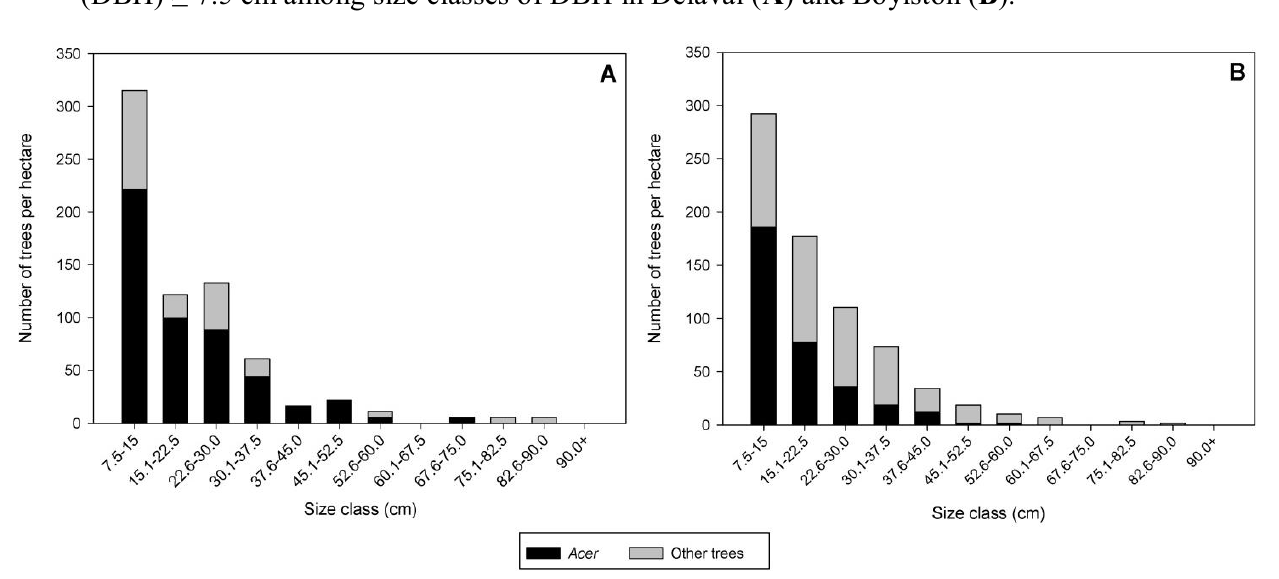
Figure 1. Distribution of Acer spp. and other hardwood trees with diameter at breast height (DBH) (cid:149)(cid:3)(cid:26)(cid:17)(cid:24)(cid:3)(cid:70)(cid:80)(cid:3)(cid:68)(cid:80)(cid:82)(cid:81)(cid:74)(cid:3)(cid:86)(cid:76)(cid:93)(cid:72)(cid:3)(cid:70)(cid:79)(cid:68)(cid:86)(cid:86)(cid:72)(cid:86)(cid:3)(cid:82)(cid:73)(cid:3)(cid:39)(cid:37)(cid:43)(cid:3)(cid:76)(cid:81)(cid:3)(cid:39)(cid:72)(cid:79)(cid:68)(cid:89)(cid:68)(cid:79)(cid:3)(cid:11) A ) and Boylston ( B